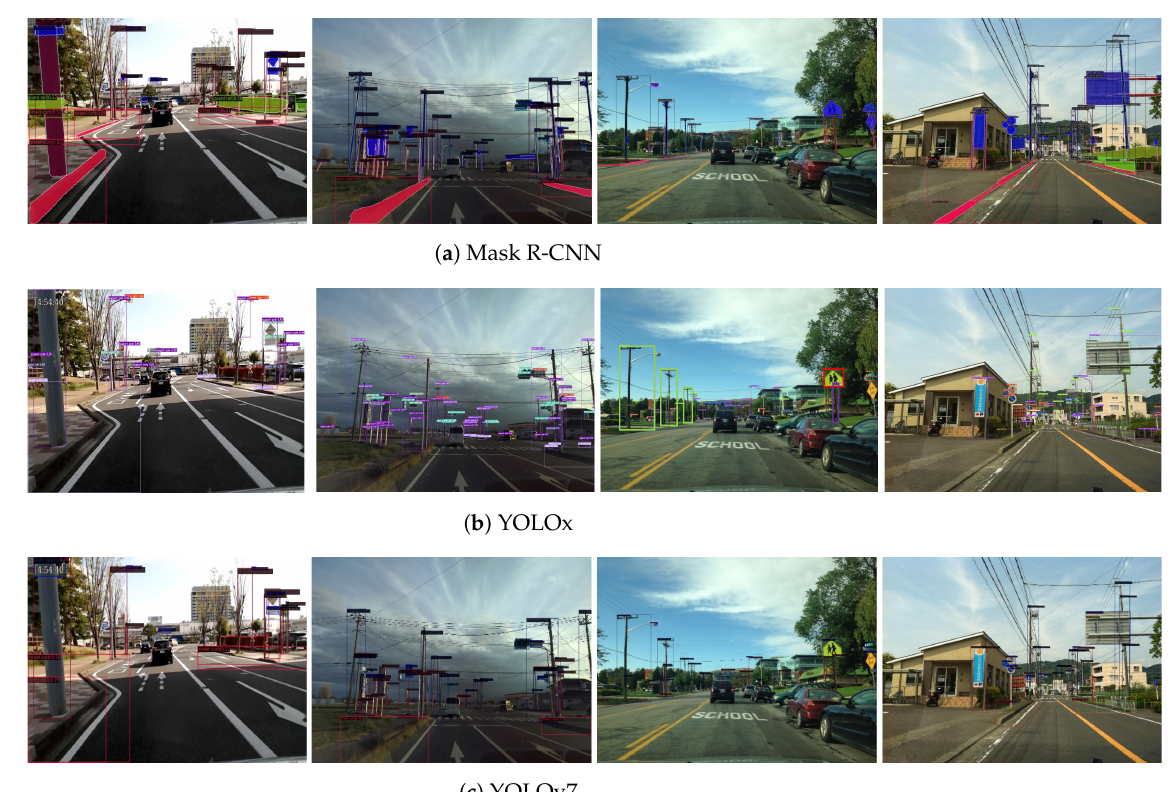
Figure 6. Qualitative comparsion of output from different models on custom dataset and Mapil- lary